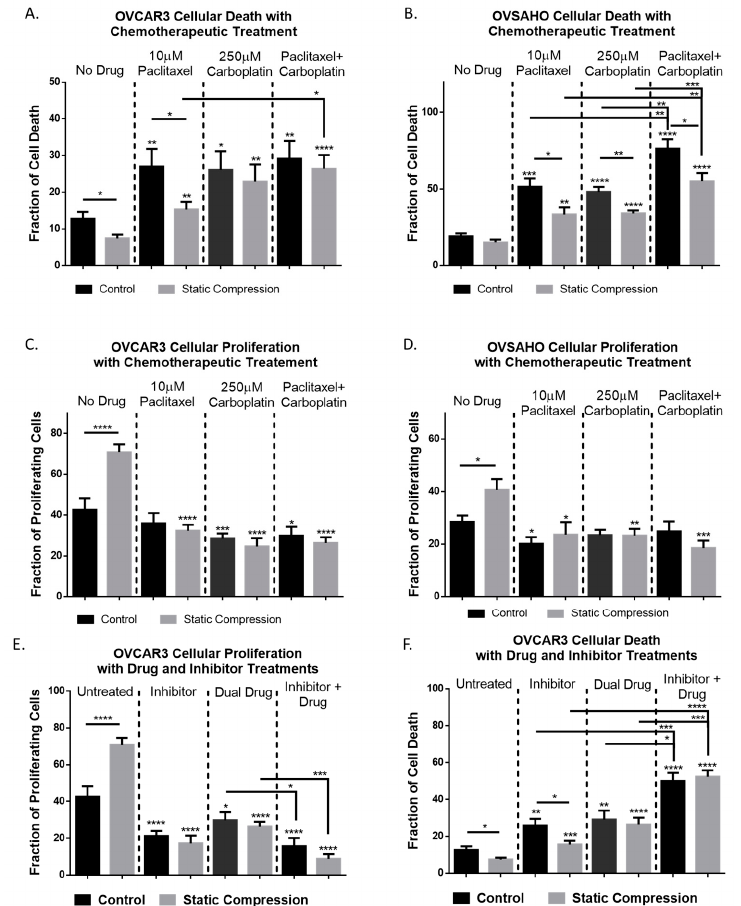
Figure 4. Compressive stimulation of ovarian cancer cells causes chemoresistance which can be mitigated through concurrent ML141 100 µ M treatment over 24 h. Star indicators located directly above a column indicates significant change when compared to the non-drug treated control / compression condition respectively. ( A ) OVCAR3 cellular death rates in response to paclitaxel, carboplatin, and combination treatments. Significant reduction in cell death is observed under compressive paclitaxel treatment. ( B ) OVSAHO cellular death response to chemotherapeutic treatments. Significant reduction in cell death is observed in all compression conditions when compared to non-stimulated drug-treated controls. ( C ) OVCAR3 proliferation responses to chemotherapeutic treatments. Drug treatments effectively target enhanced proliferation caused by compressive stimulus. ( D ) OVSAHO proliferation responses to chemotherapeutic treatments show compression induced proliferation enhancement effectively mitigated by drug administration. ( E ) OVCAR3 proliferation response to CDC42 inhibitor treatment, dual drug chemotherapy, and combined treatment. ( F ) OVCAR3 cellular death rates in response to CDC42 inhibitor treatment, dual drug treatment, and combination therapy. Combination therapy more effectively targets proliferating cells and improves cell death count compared to either treatment alone. (Significance calculated via t-test; n ≥ 3 experimental replicates, **** p < 0.0001, *** p < 0.001, ** p < 0.01, * p < 0.1).